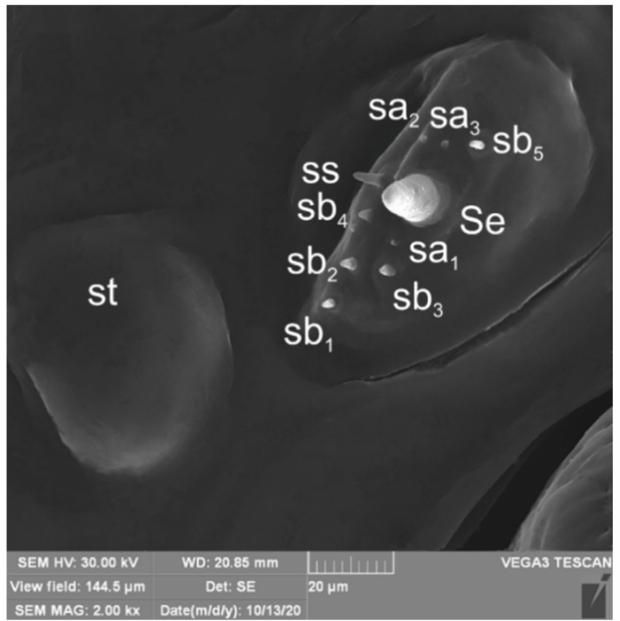
Figure 15. Rhinocyllus alpinus mature larva, antenna SEM photo (sa—sensillum ampullaceum, sb— sensillum basiconicum, Se—sensorium,